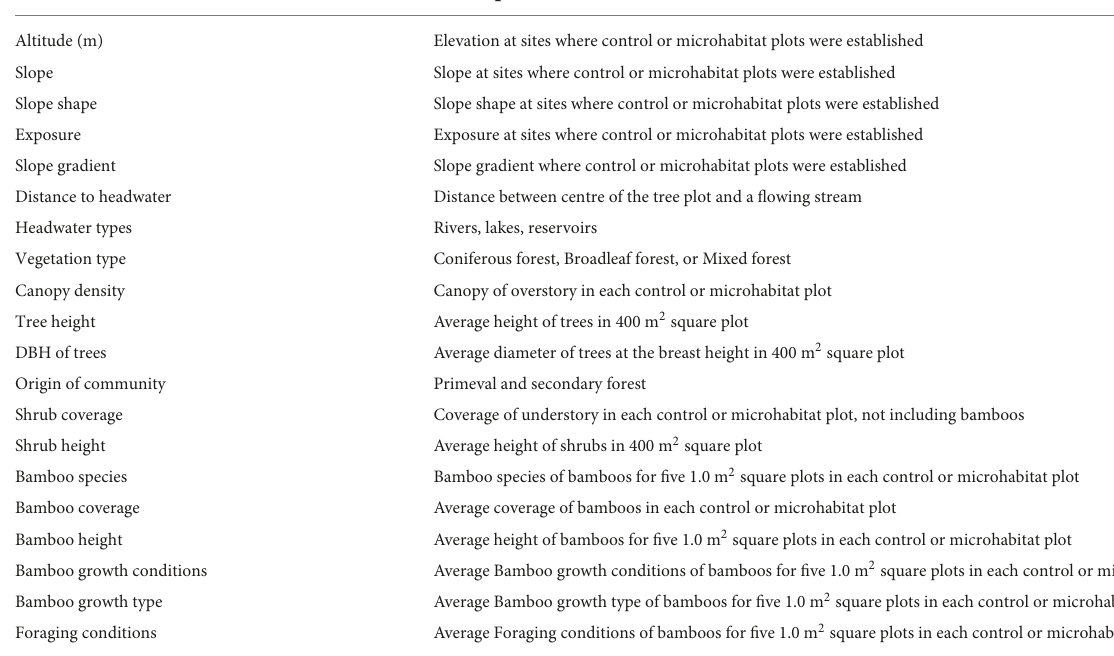
TABLE 1 Description and definitions of variables in the study. Microhabitat